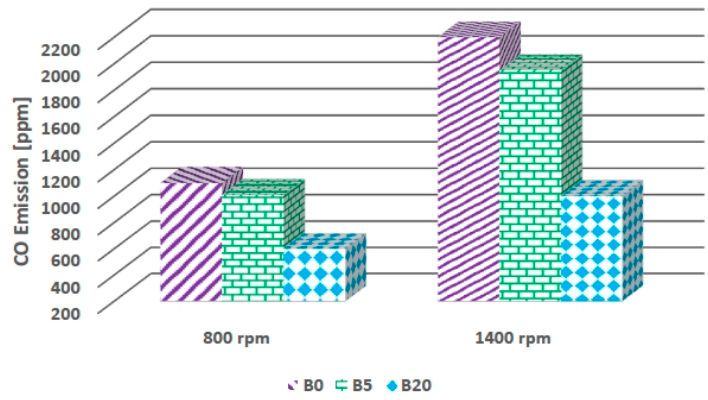
Figure 8. Variation of carbon monoxides emission with speeds.